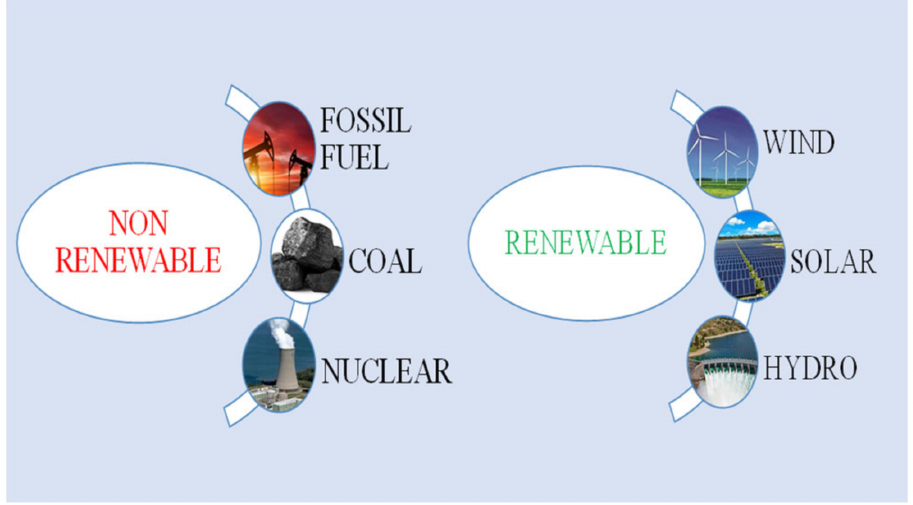
Figure 1. Renewable and non-renewable energy sources.